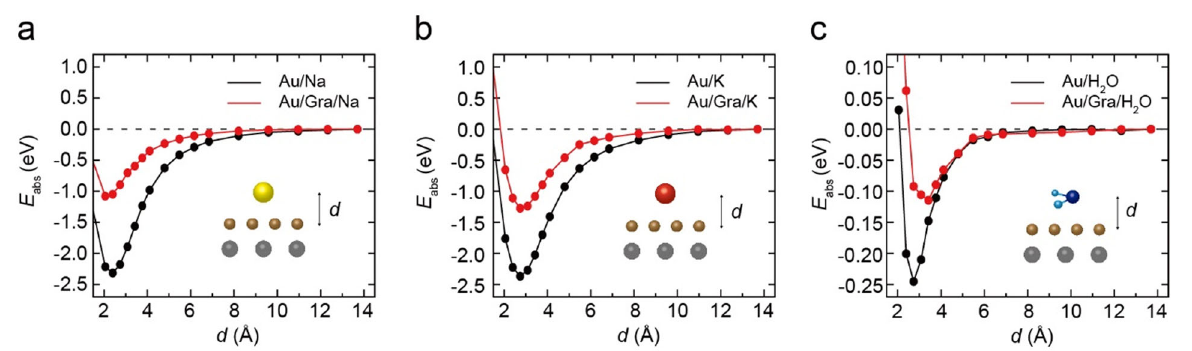
Fig. 2 The effect of graphene on the absorption energy of adsorbates. a – c Calculated absorption energies as a function of the distance from the Au or Au/graphene surface to a Na, b K, and c H 2